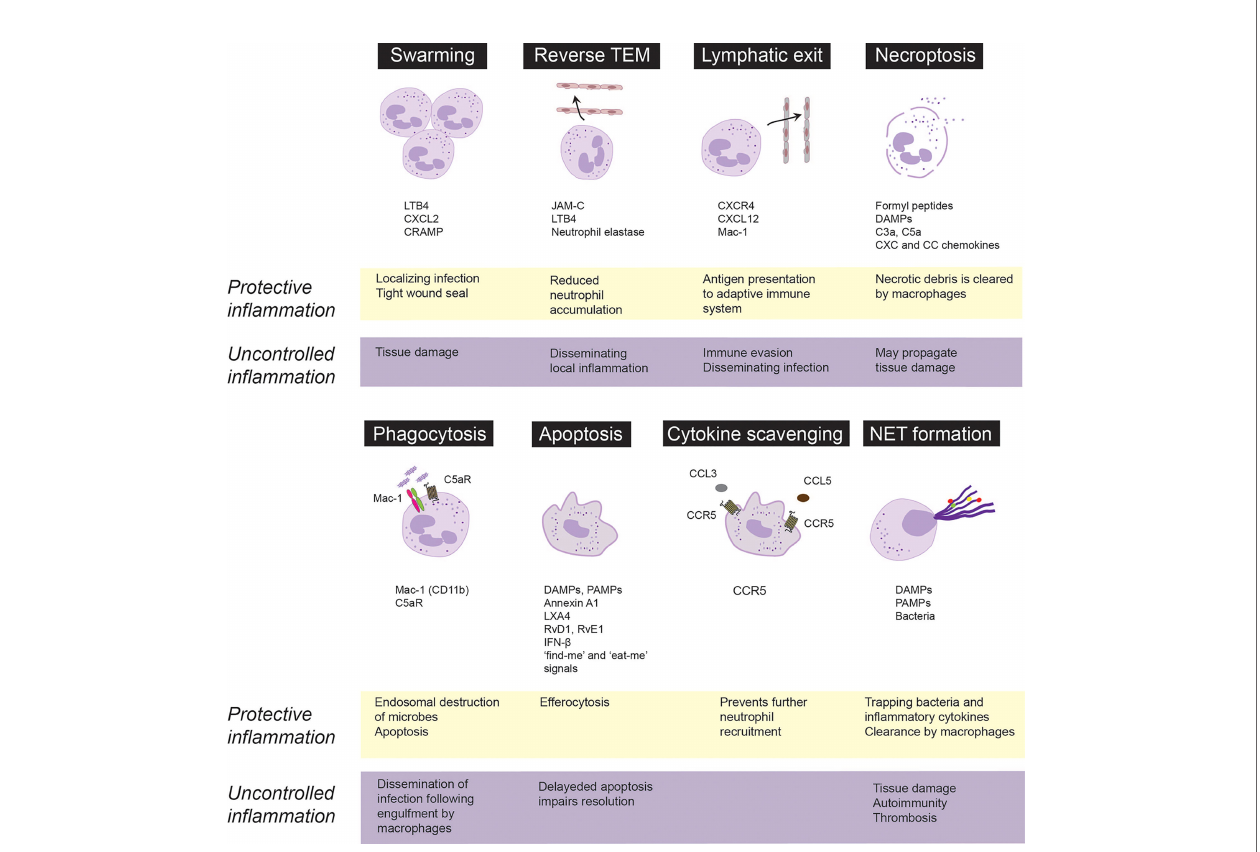
FIGURE 1 | Fate and roles of emigrated neutrophils in protective vs. uncontrolled in fl ammation. Neutrophils are rapidly recruited from the circulation to the infected or injured tissues. Following extravasation, neutrophils swarm toward the infected sites to localize infection and from a tight wound seal. Neutrophils may trap, neutralize and kill invading pathogens through necroptosis, phagocytosis or release of extracellular traps (NETs). Phagocytosis of opsonized bacteria usually induces apoptosis followed by phagocytosis of apoptotic cells by macrophages via efferocytosis. Neutrophils integrate pro-survival and apoptosis-promoting cues from the in fl ammatory environment, which governs their lifespan. Apoptotic neutrophils express CCR5, which by binding chemokines prevents further neutrophil recruitment. Excessive swarming and necroptosis may aggravate and perpetuate tissue damage. Neutrophils may egress from the in fl ammatory locus through reverse transendothelial migration (TEM) or lymphatic vessels, which dampen neutrophil accumulation, but may also lead to immune evasion and dissemination of local in fl ammation. Neutrophils carrying bacteria that they cannot destroy, may serve as “ Trojan horses ” to disseminate the infection on phagocytosis of apoptotic neutrophils by macrophages. CRAMP, cathelin-related antimicrobial peptide; DAMPs, damage-associated molecular patterns, JAM-C, junctional adhesion molecules C; LTB 4 , leukotriene B 4 ; LXA 4 , lipoxin A 4 ; PAMPs, pathogen-associated molecular patterns; RvD1, resolvin D1; RvE1, resolvin